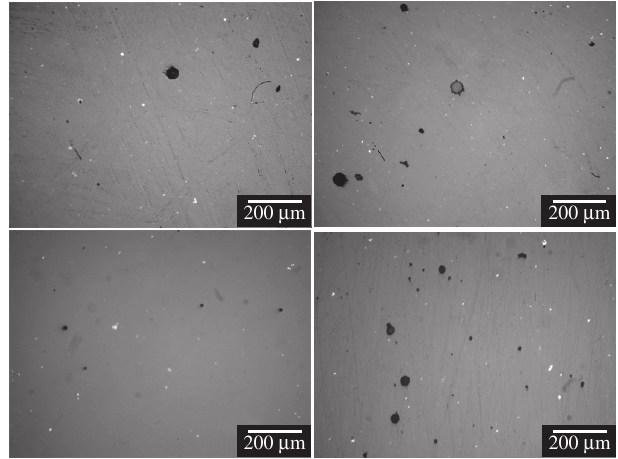
Figure 1. Optical images of polished surfaces of Empress hot-pressed at a) 1075 °C and b) 1080 °C and Empress 2 hot-pressed at c) 920 °C and d) 925